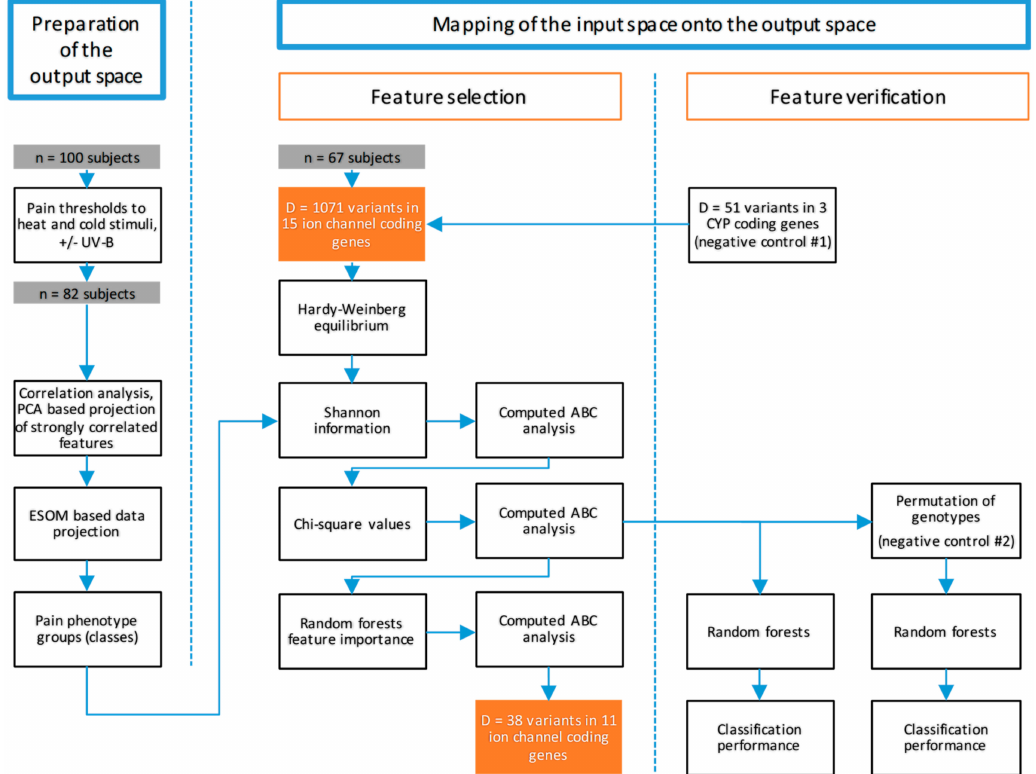
Figure 7. Flow chart of the data analysis. The figure gives an overview of the applied data science approach in two main steps (shown in blue: preparation of the output space, mapping of the input space with feature selection and verification of the genetic results). After the identification of a pain-related phenotype group structure (“output space”) based on thresholds for thermal pain and UV-B e ff ects, genetic variants in the pre-selected candidate genes coding for di ff erent thermosensitive ion channels were selected to provide the most important information to train a machine-learned algorithm implemented as a random forest with the aim to assign a subject to the correct pain phenotype group. To verify the results, the correct group assignment was tested using randomly resampled data from the original dataset, on permuted data and including negative control genes present as cytochrome P450 (CYP) gene